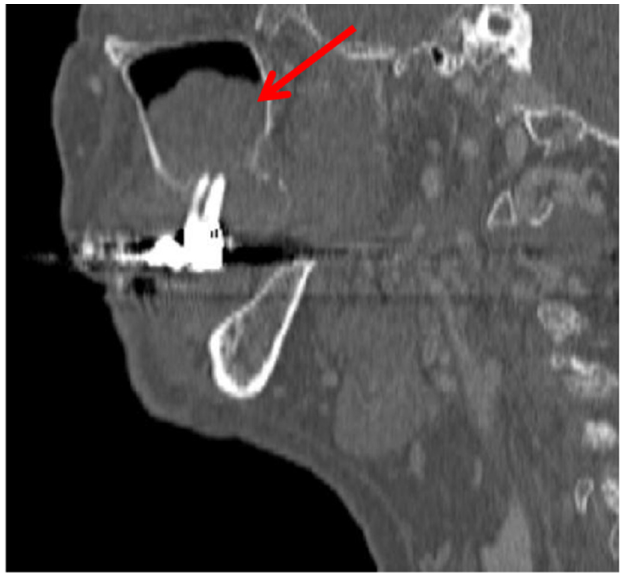
Fig. 2. Sagittal split showing the tumor, the osteolysis, and the relationship with the upper maxillary left molar.